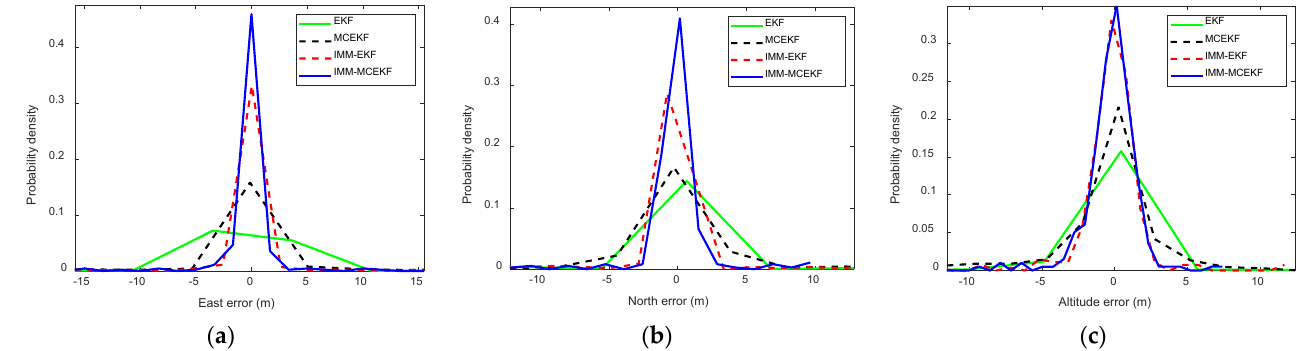
Figure 9. Comparison between the navigational accuracy and the corresponding pdfs of the alti- tude position errors: ( top ) navigational accuracies for EKF vs. ( a ) IMM–EKF, ( b ) MCEKF, and ( c ) IMM–MCEKF, and ( bottom ) pdfs of position errors for EKF vs. ( d ) IMM–EKF, ( e ) MCEKF, and ( f ) IMM–MCEKF.